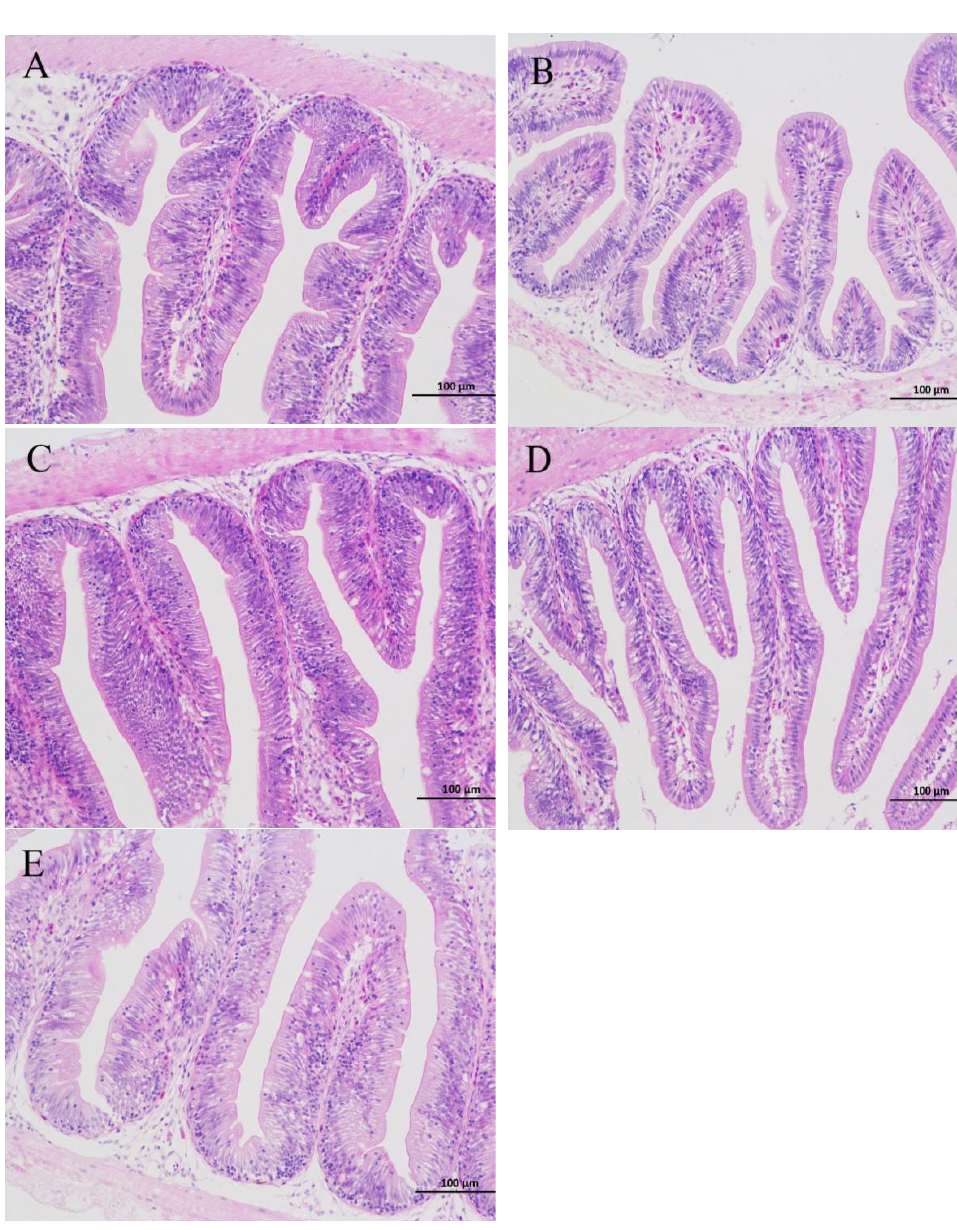
Figure 1. The intestine sections HE staining of the GIFT with different ELE levels (200×). 0% ELE ( A ), 0.02%ELE ( B ), 0.04%ELE ( C ), 0.06%ELE ( D ), and 0.08%ELE ( E ). Table 8. The effects of ELE on the intestinal morphology of the GIFT. Parameters